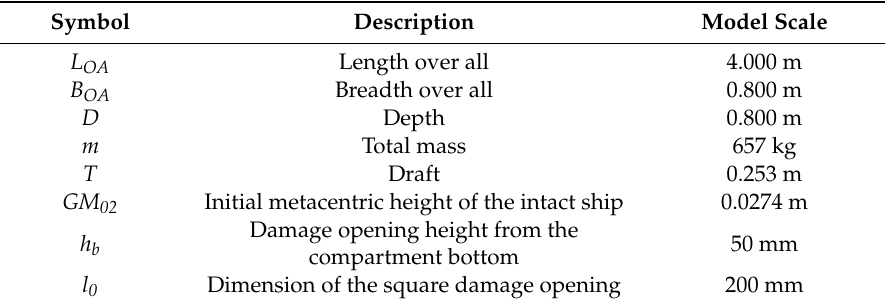
Figure 3. General arrangement and compartment details of the barge model. Flooding of the compartment, R11, is investigated. Table 1. Main particulars of the barge model.